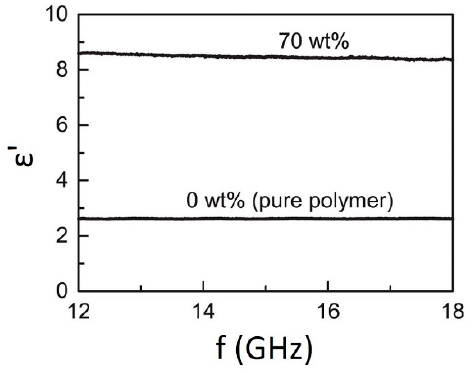
Figure 4. The permittivity ε′ as a function of frequency for ABS polymer only, and 70 wt.% BT/ABS polymer composite (available under Creative Commons license [58]).